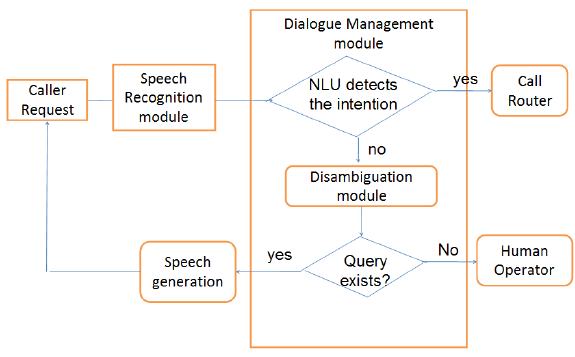
Figure 1: The general framework of a natural language call